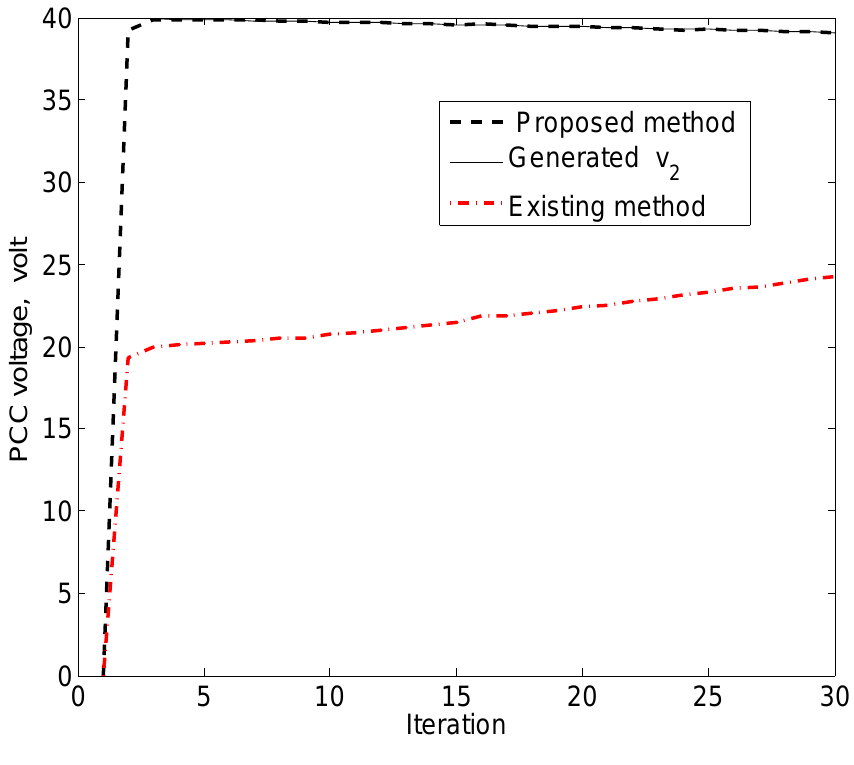
Figure 12. PCC voltage estimation for v